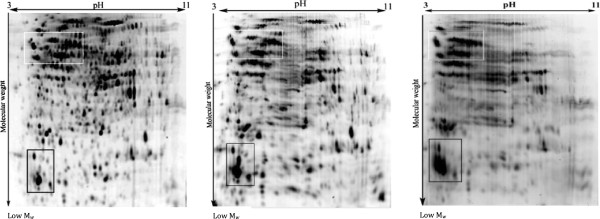
2D-DiGE of A. senegalensis preserved at −21 (left), 4 (middle) and 35°C (right). The proteins were pre-stained with Cy3 before separation. As it is evident, slight and moderate streaking and trains of spots were formed in the proteome pattern of cells kept at 4 and 35°C. The density of high molecular weight proteins at the basic side of the gel decreased at 35°C. The selected sections (white and black rectangles) show clearly the differences between the patterns of proteins.